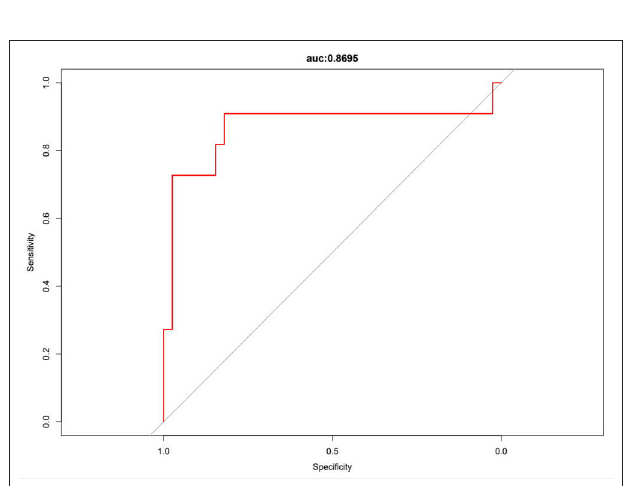
FIGURE 6 | Receiver operating characteristic (ROC) curve of the prediction